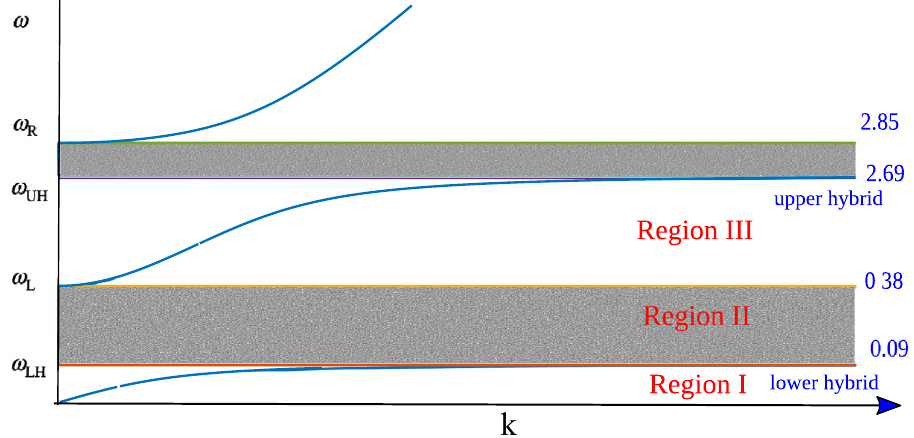
Figure 1. Dispersion of X-mode when � k ⊥ � B 0 , classified into three regions. The numbers on the right hand side correspond to resonance and cutoff frequencies for m i = 100 m e in normalized